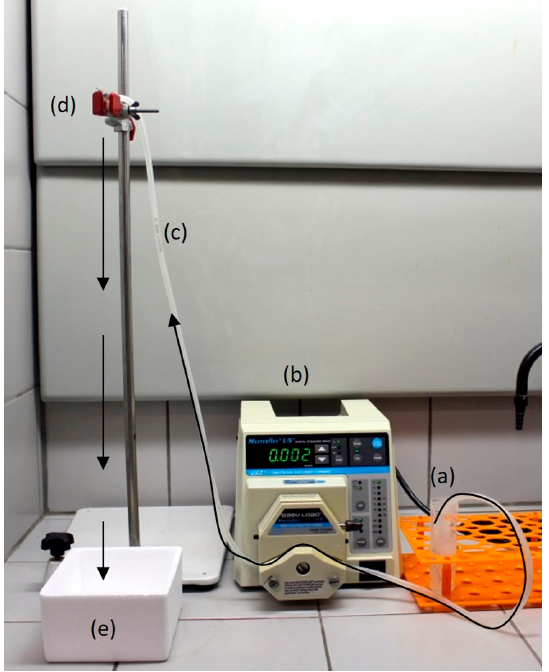
Figure 1. Experimental setup for beads syntheses: ( a ) natural polymer solution; ( b ) peristaltic pump; ( c ) silicone hos; ( d ) needle and ( e ) liquid nitrogen.